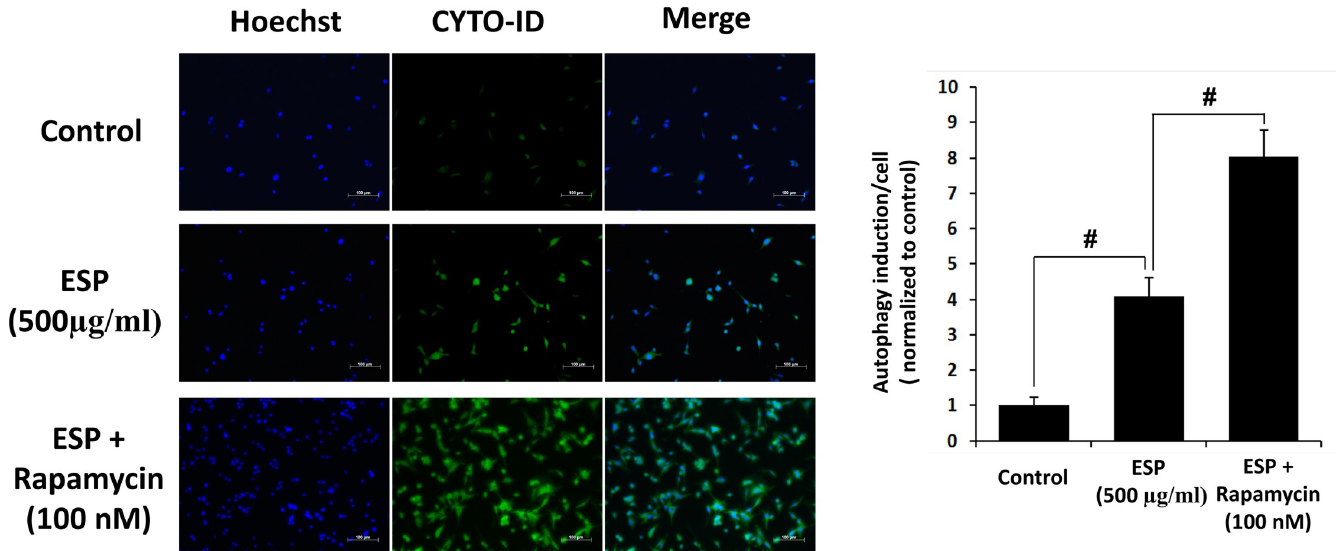
Fig 5. Immunofluorescence staining of autophagy-related proteins in excretory/secretory product-treated astrocytes. Cells were pretreated with 100 nM rapamycin for 1 h and then incubated with 500 μ g/ml of A . cantonensis L5 excretory/secretory products (ESPs) for 12 h. Immunofluorescence staining was used to detect the expression of autophagy-related proteins (blue: nucleus; green: autophagy). https://doi.org/10.1371/journal.pntd.0008290.g005 elevated upon treatment with 62.5 and 31.3 μ g/ml ESPs and that Ptch, Smo, and Gli-1 were sig- nificantly elevated upon treatment with 62.5 μ g/ml ESPs (Fig 8). These results confirm that ESPs activate the Shh signaling pathway in astrocytes.